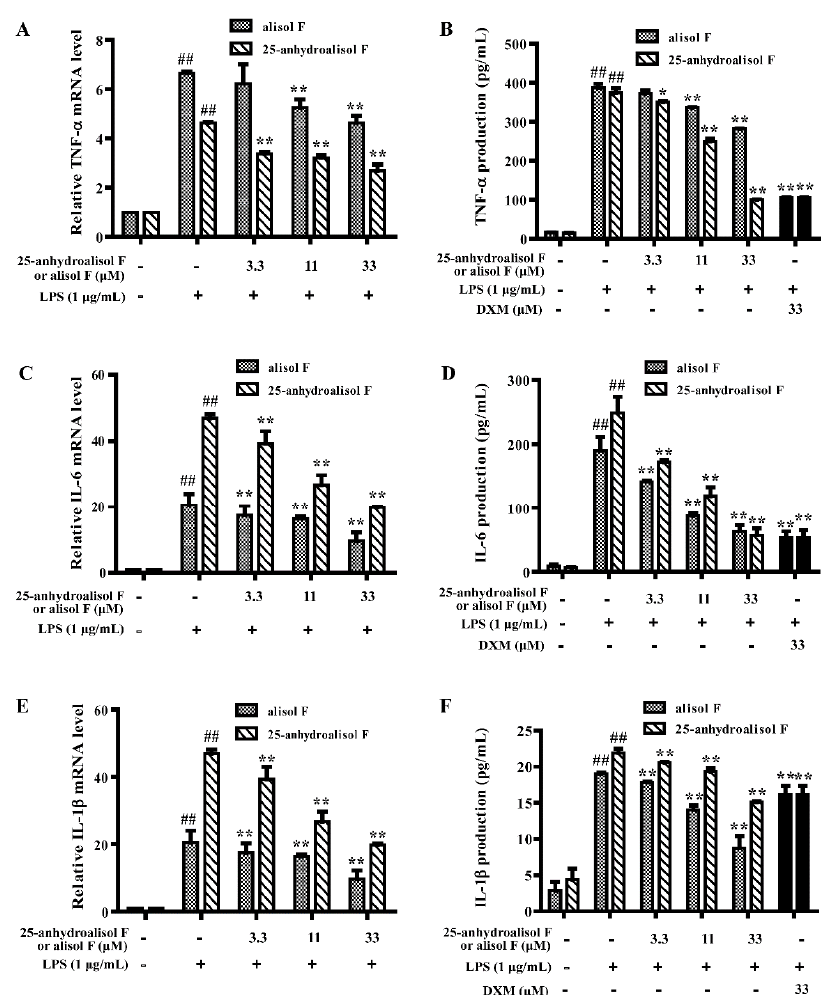
Figure 3. The effects of alisol F and 25-anhydroalisol F on LPS-induced expression and production of TNF- α , IL-6 and IL-1 β in RAW 264.7 cells. The cells were pretreated with the different concentrations of alisol F (0, 3.3, 11 and 33 μ M) and 25-anhydroalisol F (0, 3.3, 11 and 33 μ M) for 2 h and then stimulated with or without LPS (1 μ g/mL) for 4 h. The expression of TNF- α ( A ); IL-6 ( C ); and IL-1 β ( E ) were determined by quantitative real-time PCR. The culture media were collected after 24 h LPS treatment, the production of TNF- α ( B ); IL-6 ( D ); and IL-1 β ( F ) were measured using the ELISA kits. The dexamethasone (DXM) was used as the positive control. The data represent the means ± S.E. of three independent experiments. ( ## p < 0.001 vs. control group; * p < 0.05; ** p < 0.001 vs. LPS group).